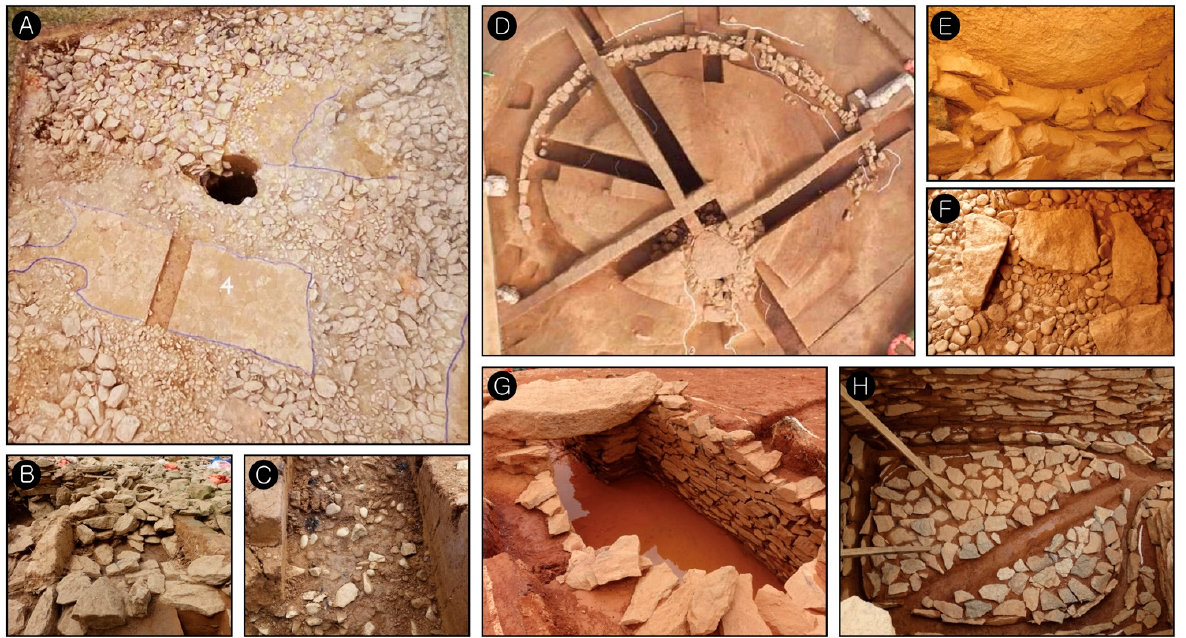
Figure 2. Research-target tombs: ( A – C ) show distribution of stone materials composing Seokchon- dong connected stone-mound tombs; ( D – F ) are in Bangi-dong No.3 tomb; ( G , H ) show representative distribution in Gamil-dong tomb complex.